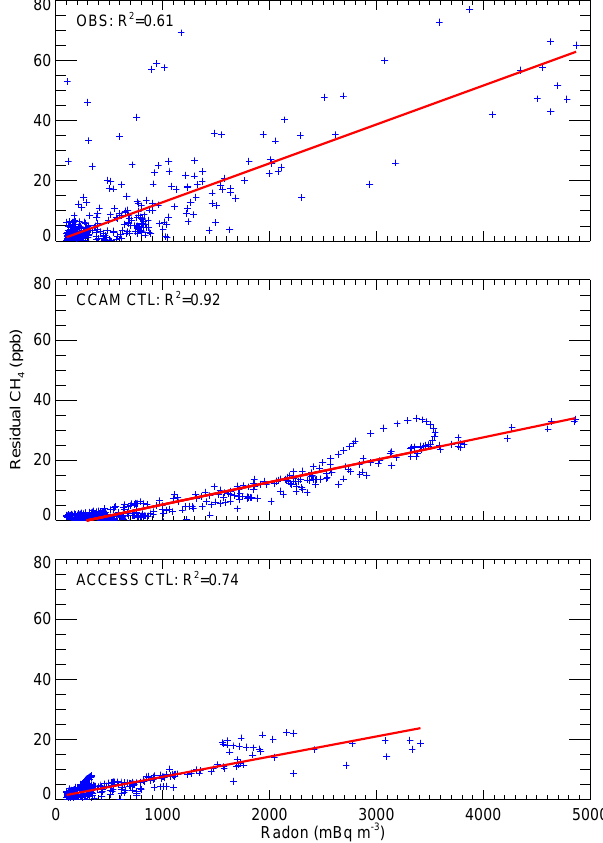
Figure 6. Scatter plots of methane to radon, with linear fits for Jan- uary 2006. The upper panel shows the observational data, the mid- dle panel the CCAM data and the lower panel the ACCESS